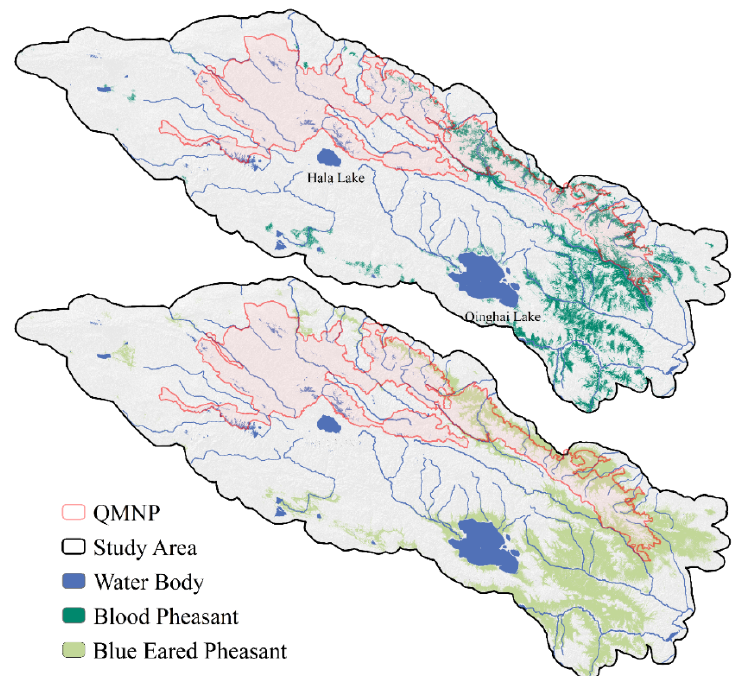
Figure 2. Binary map of the potential distribution of blood pheasants and blue eared pheasants. The range of the Qilian Mountains National Park (QMNP) is highlighted in red.